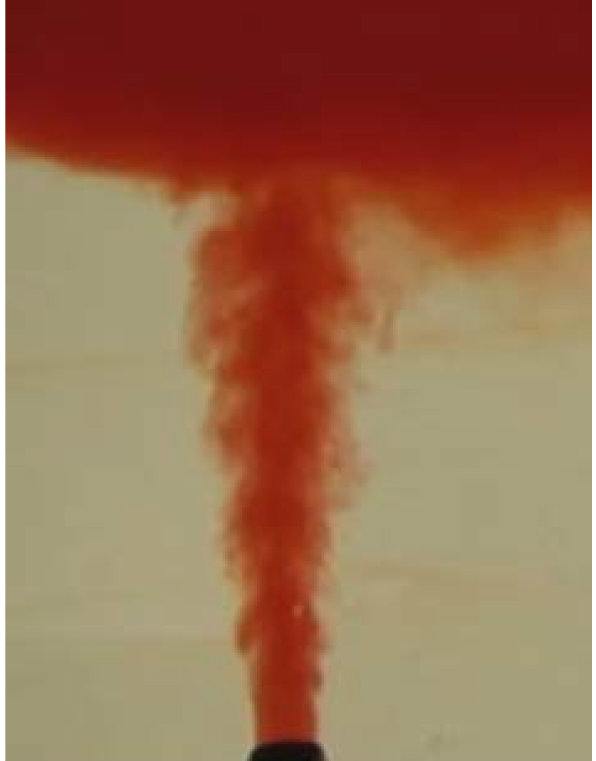
Figure 16. A snapshot from a movie (Carazzo et al., 2014, Supple- ment Movie S3) recording an experiment simulating a volcanic vent in a stratified water